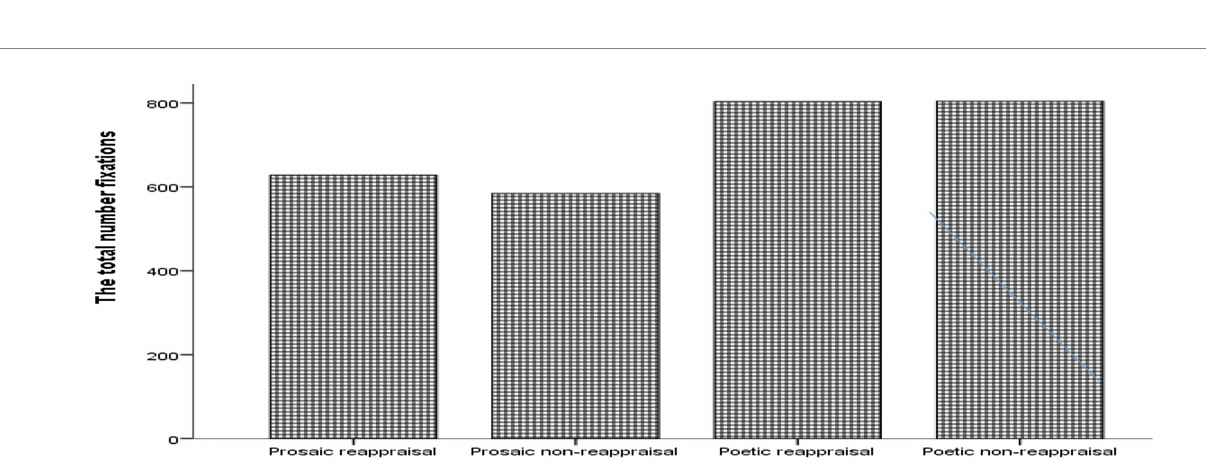
FIGURE 3 Bar graph showing the total number of fixations by text type.